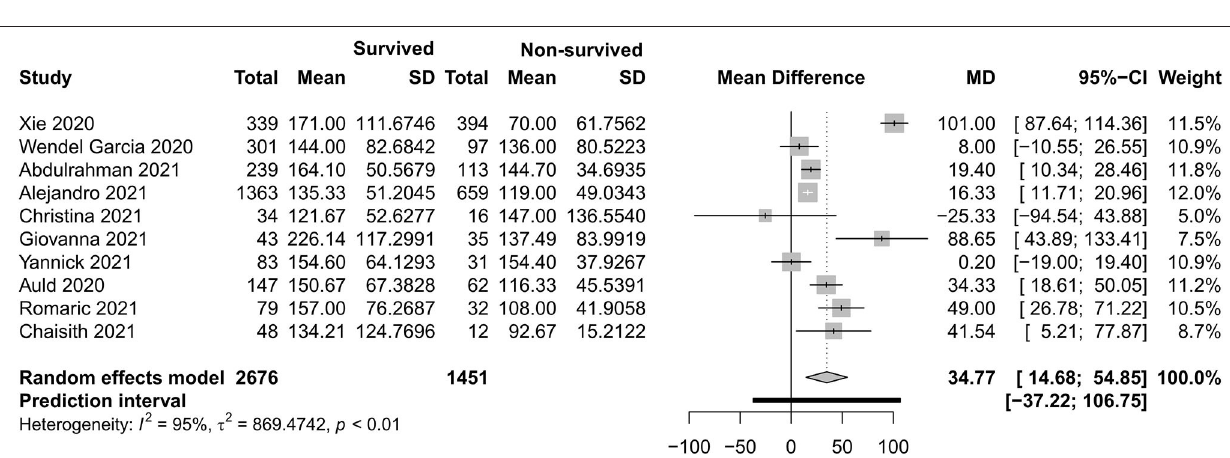
FIGURE 6 | Mean difference of Sequential Organ Failure Assessment score between survived and non-survived patients.